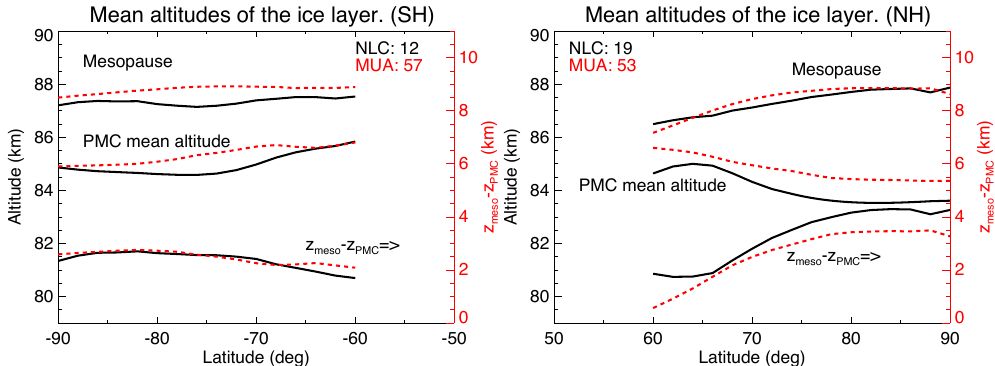
Figure 7. Mean altitudes of the mesopause ( z meso ), of the PMC layer ( z PMC ), and the difference z meso − z PMC (right y axis) for the SH (left) and the NH (right) seasons for all measurements. The different colours indicate the results for the NLC (black) and MUA (red) MIPAS observation modes (see Table